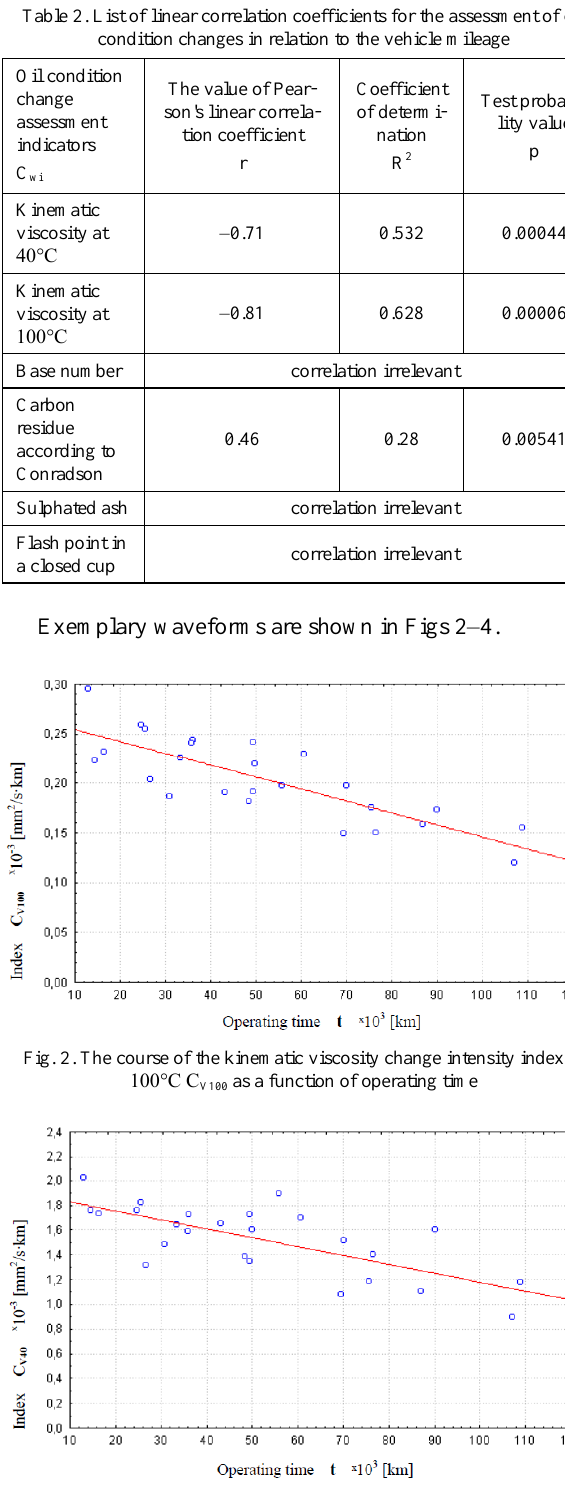
Fig. 3. The course of the kinematic viscosity change intensity index at 40°C C V40 as a function of operating